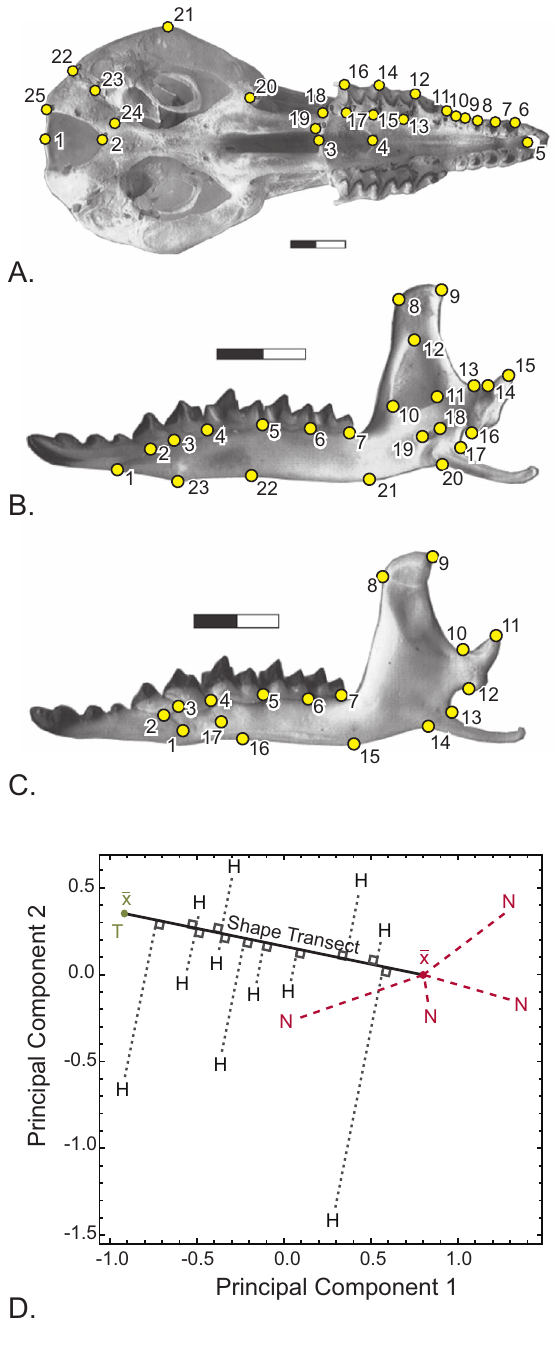
Figure 3. Landmark scheme. Landmarks of the ventral cranium (A), medial mandible (B), and lateral mandible (C). D. Example (Novosibirsk- Tomsk hybrid zone) showing graphically how the shape transect is calculated. A line is drawn through multivariate shape space between the two means of the pure race localities and the means of the hybrid localities are projected onto it. The result is a univariate axis that best describes the gradient in shape from one side of the hybrid zone to the other. For simplicity, the projections of the hybrids in this example all project between the means of the two races, but in reality they may also project outside